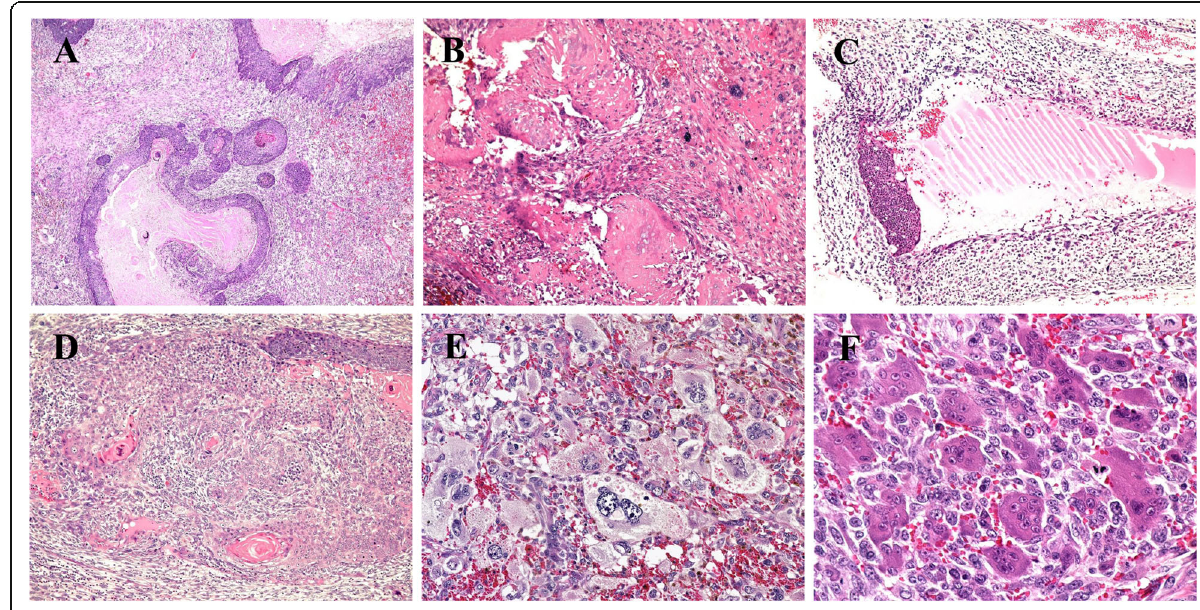
Fig. 1 Tumor patterns, hematoxylin eosin staining. HE staining showing a : follicular differentiation of carcinoma components (×4), b : “ shadow cell ” and foreign body giant cells (×10), c : cystic change with partial coverage in basaloid cell carcinoma × 10, d : squamous cell carcinoma component (× 10), e : pleomorphic spindle cell sarcoma (UPS) × 10, and f : spindle cells with osteoclast-like giant cells